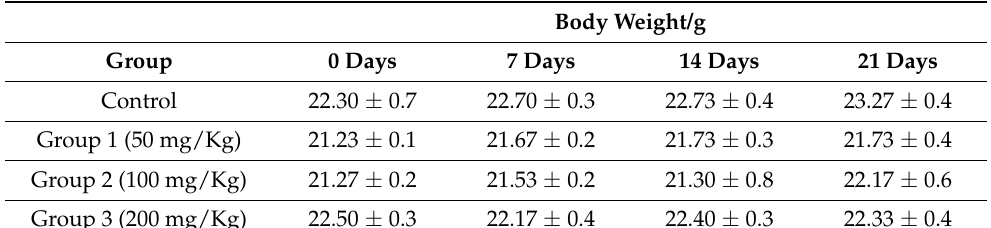
Table 8. Effect of the administration of a novel nutraceutical in three different concentrations on the body weight (g) of mice.